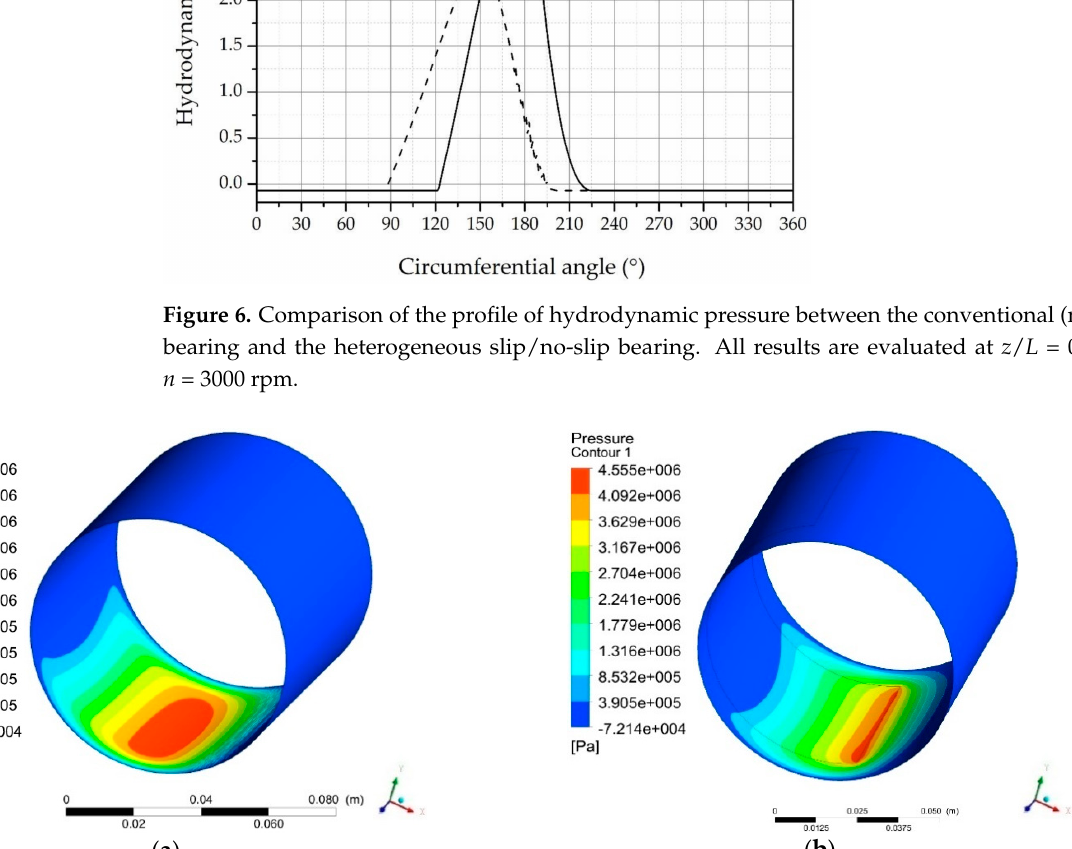
Figure 8. Comparison of the load-carrying capacity between the conventional (no-slip) bearing and the heterogeneous slip/no-slip bearing at different rotational speeds. All results are evaluated at z / L = 0.5. Another interesting finding regarding the benefit of the use of a heterogeneous slip/no-slip pattern is in terms of temperature distribution over the contacting surface. Figure 9 depicts the comparison of the temperature profile between the conventional (no- slip) bearing and the heterogeneous slip/no-slip bearing. The temperature distribution in the plot suggests that the slip boundary in heterogeneous slip/no-slip form is able to de- crease the temperature profile significantly. Meanwhile, it can also be observed that the location of the temperature jump shifts from the bearing angle θ = 90 o to the θ = 120 o . Color distribution in the contour of temperature, as shown in Figure 10, illustrates that the high-temperature zone occurs at the mid-plane both in the case of conventional and heterogeneous slip/no-slip patterns. Looking at the configuration of the oil-lubricant tem- perature, it can be revealed that the differences in the oil-lubricant temperature profile for the two kinds of bearings considered here exist in the values of local temperature along